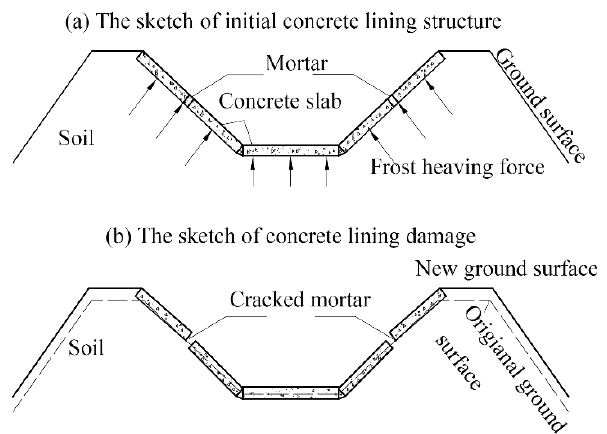
Figure 2. The sketch of mechanical failure of the concrete slabs joints. ( a ) The sketch of initial concrete lining structure. ( b ) The sketch of concrete lining damage.